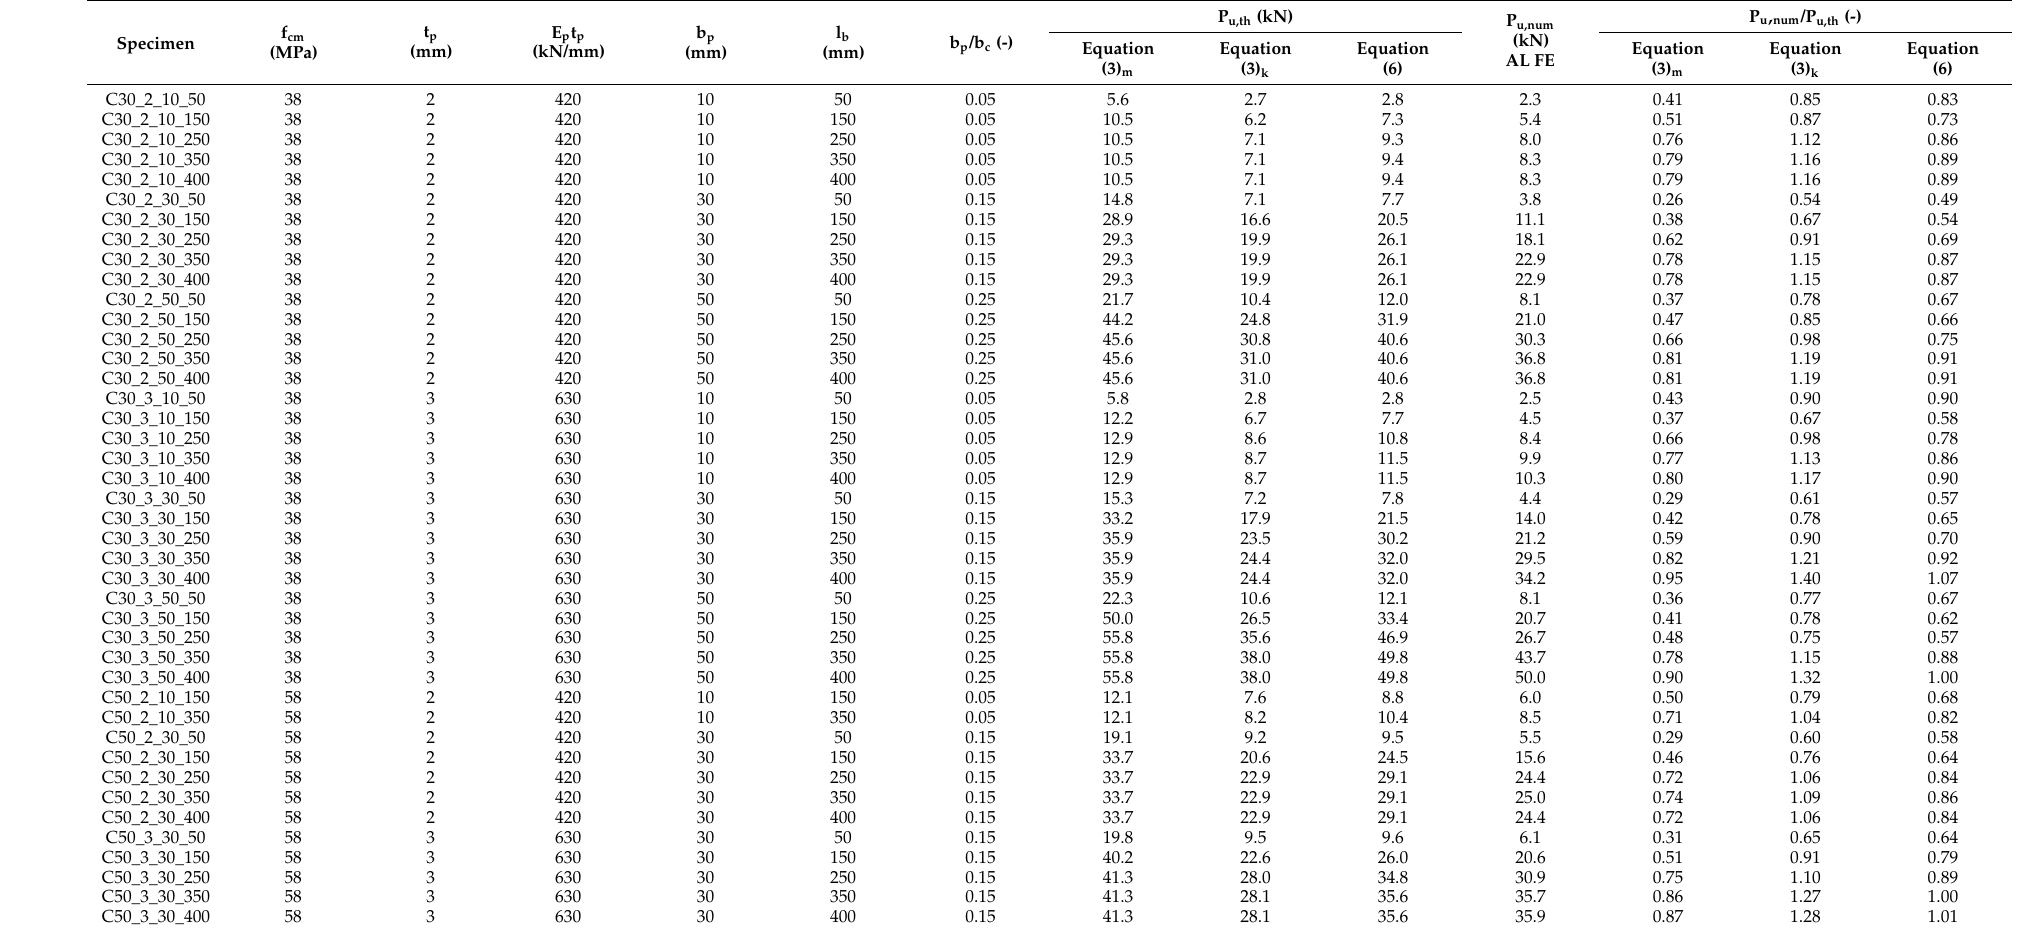
Table 3. Geometries of simulated specimens and maximum debonding loads according to theoretical and numerical